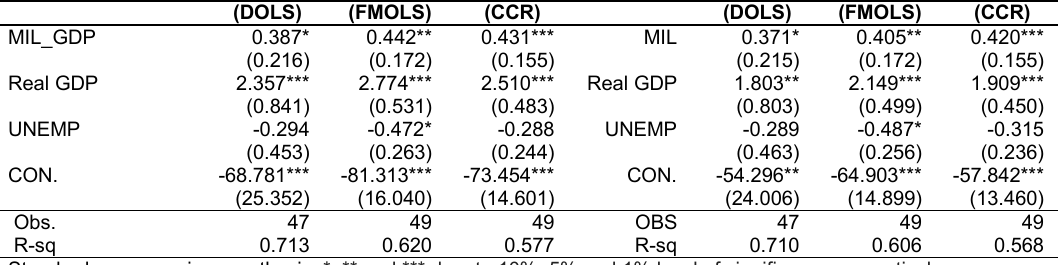
Table 7. Robustness: long-run effect of military spending on private investment from the DOLS, FMOLS and CCR estimation